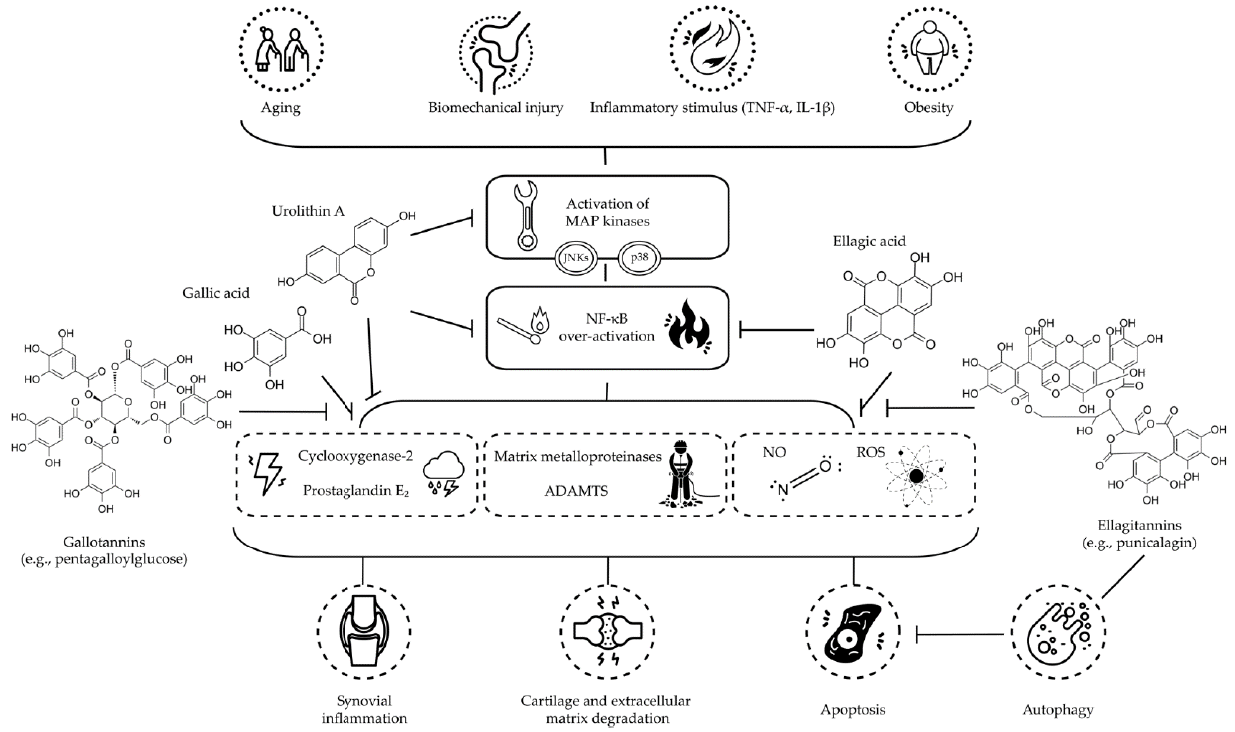
Figure 1. Schematic overview of the proposed mechanisms of action of main dietary HTs and their derived metabolites, discussed in this literature review, on OA (Abbreviations: ADAMTS: short for a disintegrin and metalloproteinase with thrombospondin motifs; IL- 1β: interleukin 1β; JNK: c -Jun N-terminal kinase; MAP: mitogen-activated protein; NF- κB: nuclear factor κ light -chain-enhancer of activated B cells; NO: nitric oxide; ROS: reactive oxygen species; TNF- α: tumor necrosis factor α).